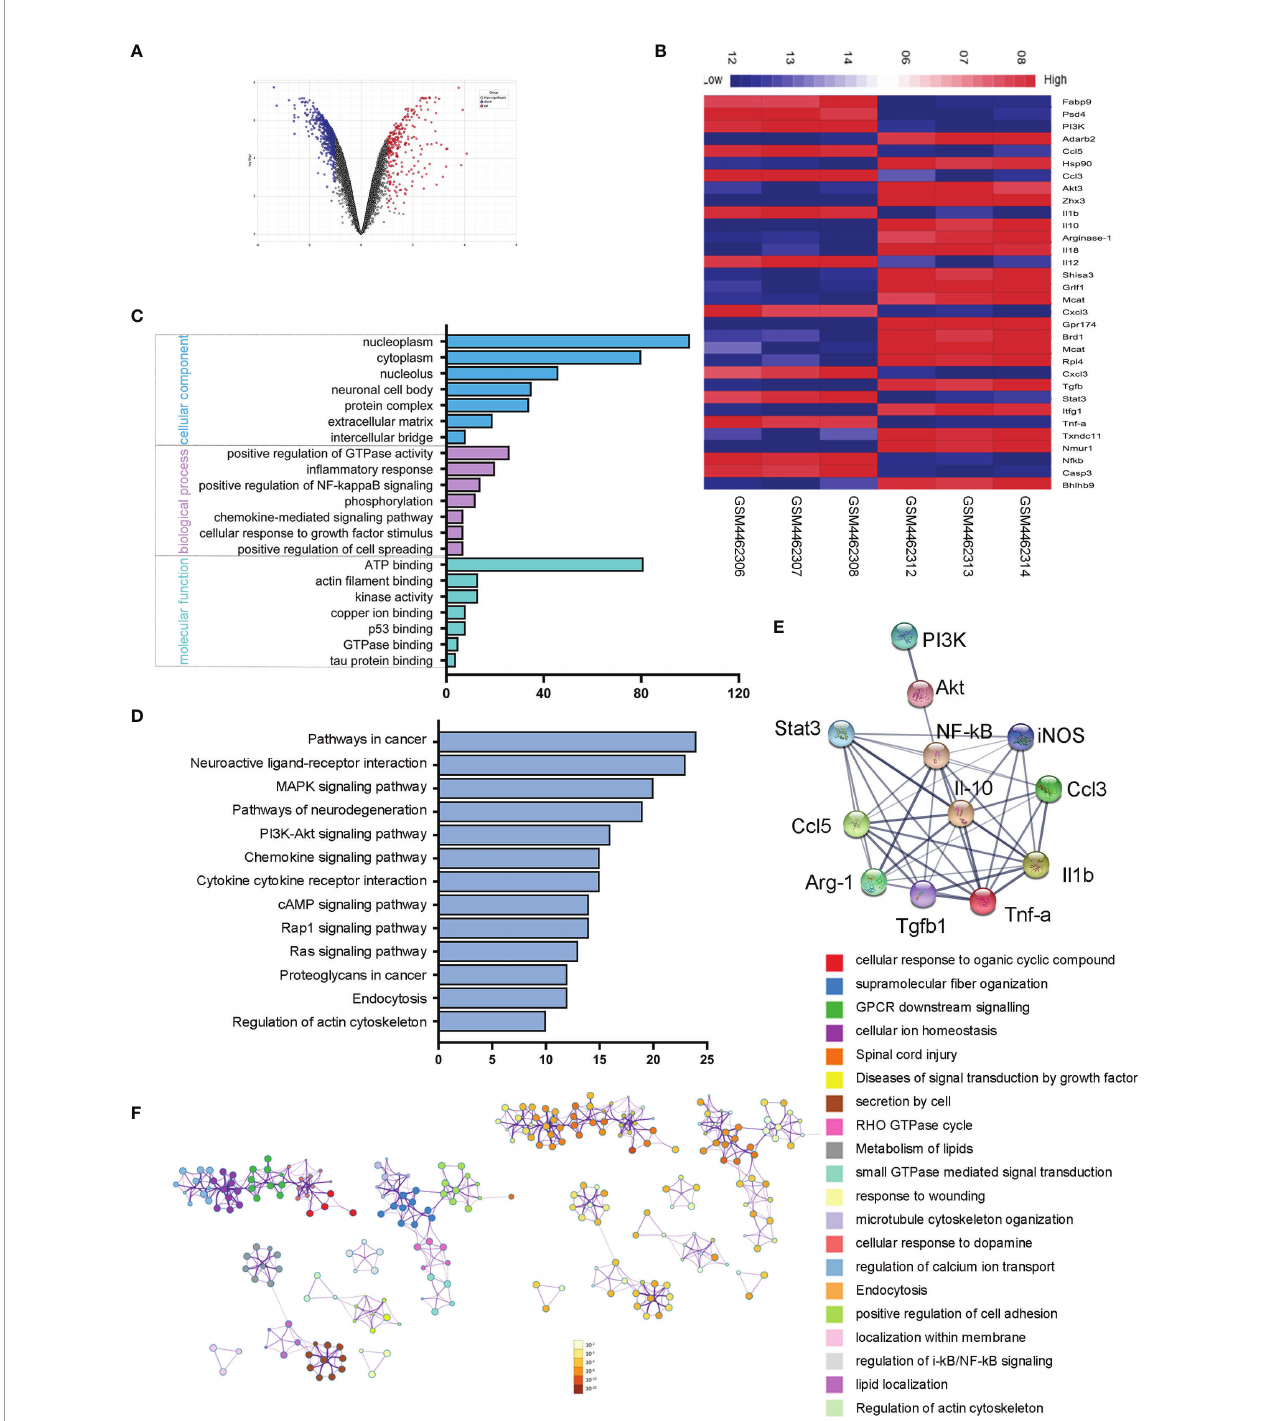
FIGURE 6 | Microglial transcriptome analysis in an ischemic rat model. (A) Volcano plot of differentially expressed genes in the stroke rat samples compared with those of normal samples from the GEO dataset. Red and blue indicate upregulated and downregulated, respectively. (B) The heatmap shows 32 genes from top 50 differentially expressed genes of microglial activation. Red and blue represent the upregulated and downregulated genes. (C) Differentially expressed genes of microglial activation are enriched by GO analysis including biological process, molecular function, and cellular component. (D) KEGG pathways enrichment for upregulated genes. (E) The PPI network of microglia-activated genes constructed by STRING. (F) Functional annotation of signi fi cantly expressed genes using Metascape. Orange denotes the enrichment terms colored by p-values and an interactive network of the enrichment terms colored by cluster